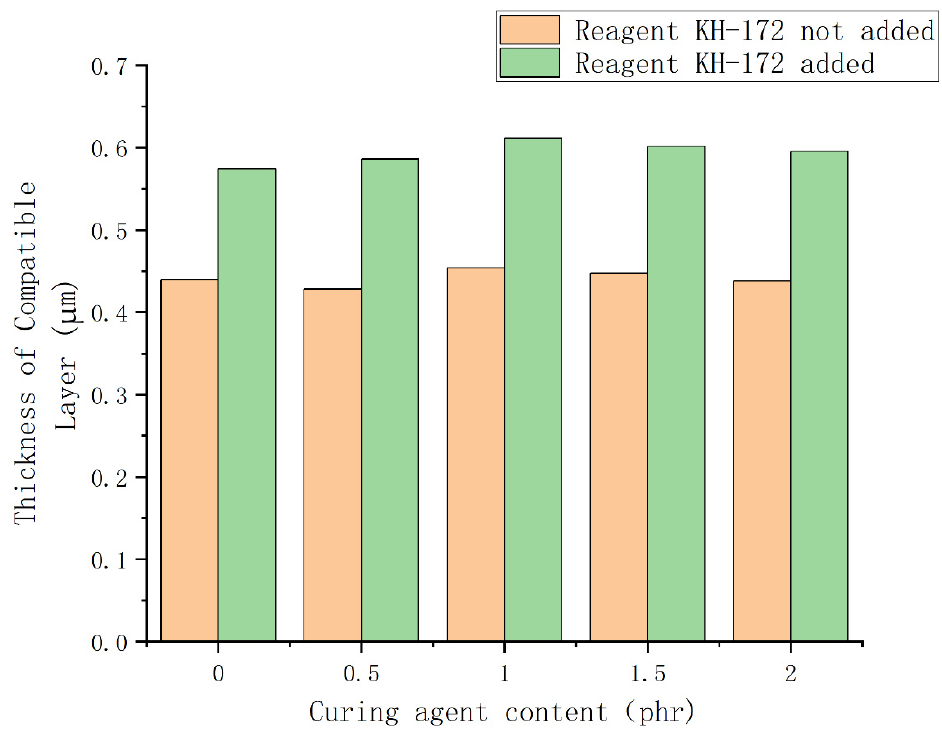
Figure 7. Thickness histogram for quantitative characterization of the compatible layer.